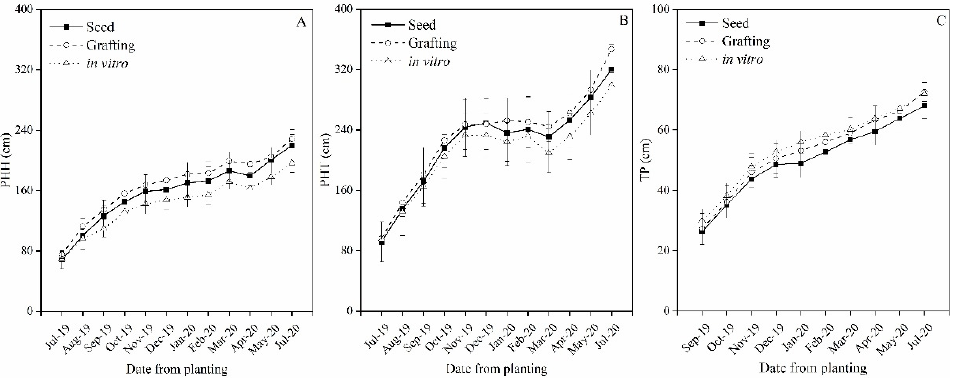
Figure 1. ( A ) Plant height from the ground to the head (PHH); ( B ) Plant height from the ground to the top of the canopy (PHT) and ( C ) Trunk perimeter (TP), in ‘Alicia’ papayas propagated by seed, grafting and in vitro.